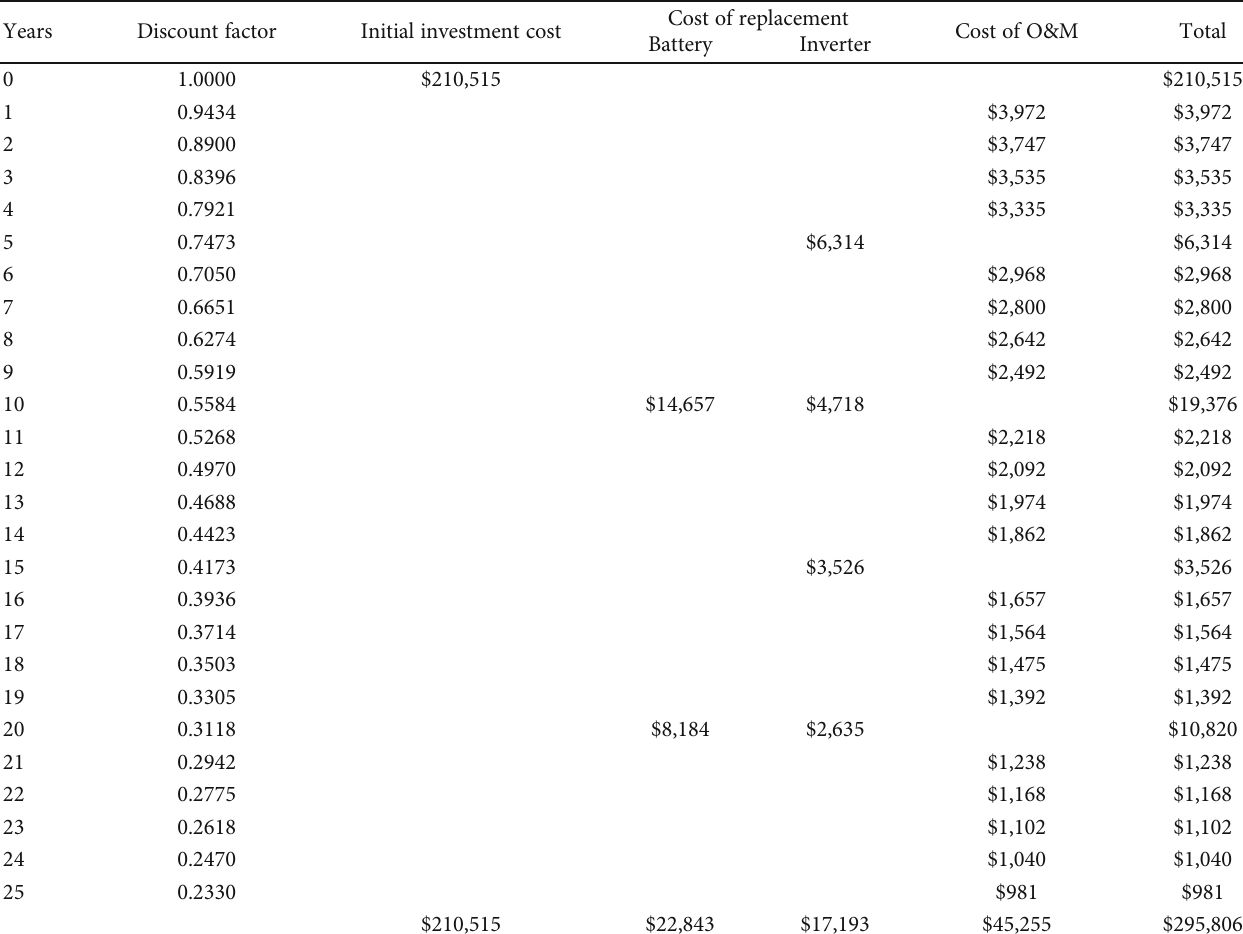
Table 4: Detail LCC of BAPV system design 1 in scenario